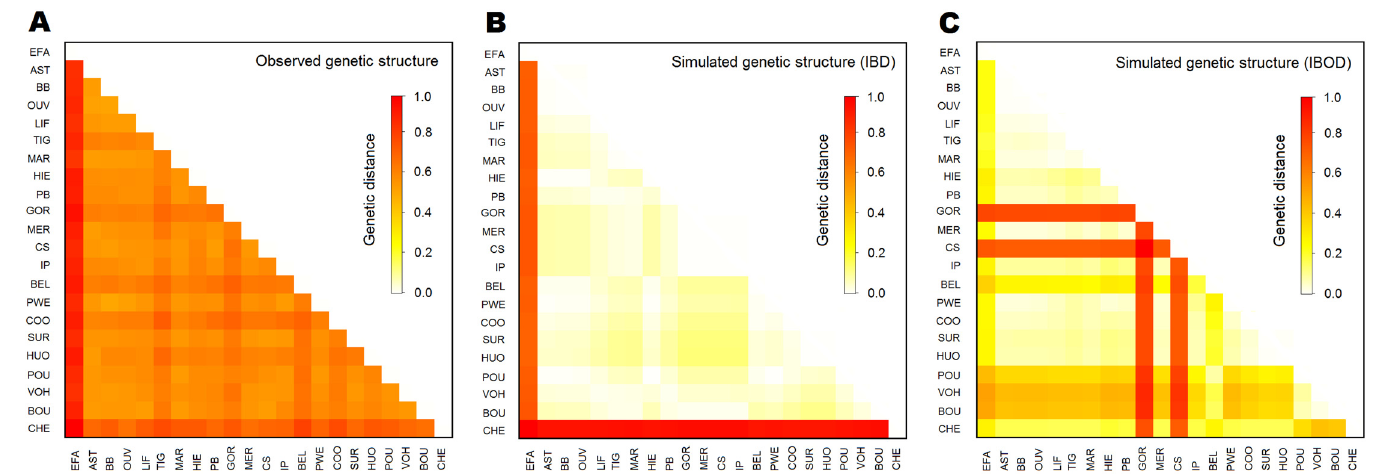
Fig 5. Comparison between observed and simulated genetic structuresfor Tridacna maxima . A) Observed geneticdistances from empiricaldata, obtainedfrom 15 microsatellite loci. B) Genetic distancessimulatedby the isolationby distance(IBD) model. C) Genetic distances simulatedby the isolation by oceanographic distance(IBOD) model. Genetic distancesare Cavalli-Sforza& Edwards’s geneticdistances [53], normalized to have maximum of 1.